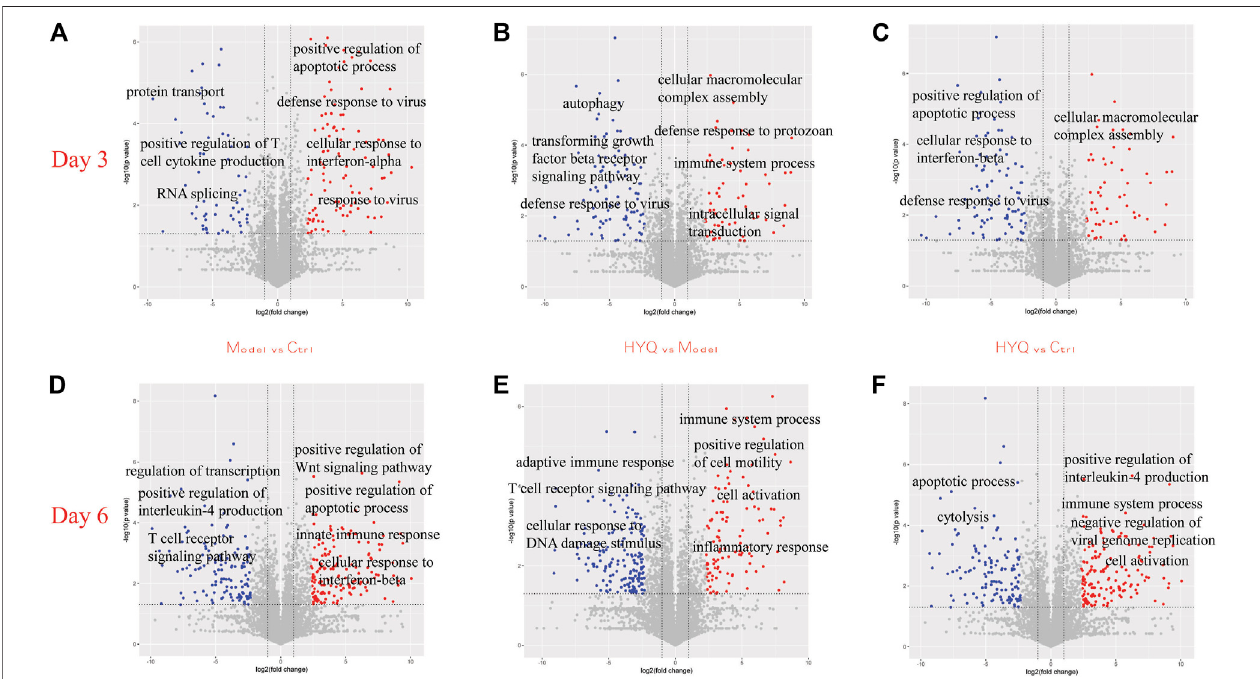
FIGURE 3 | Protein dynamics of HYQ-mediated intervention of viral pneumonia in the mouse lung at the third and sixth days after viral infection and high-dosage HYQ administration (A) Proteins ’ change at the thirdday after viral infection (model vs controlat day 3) and the biological process or molecular function ofsome proteins withsigni fi cantlydifferentexpression levels( p < 0.05) (B) Proteins ’ changeatthethirddayafterviralinfectionandhigh-dosageHYQadministration (HYQvsmodelatday 3) and the biological process or molecular function of some proteins with signi fi cantly different expression levels ( p < 0.05) (C) Proteins ’ change between high- dosageHYQadministrationandcontrolatthethirdday(HYQvscontrolatday3) (D )Modelvscontrolatday6 (E) HYQvsmodelatday6 (F) HYQvscontrolatday6.Ctrl: control. Days 3 and 6: virus infection